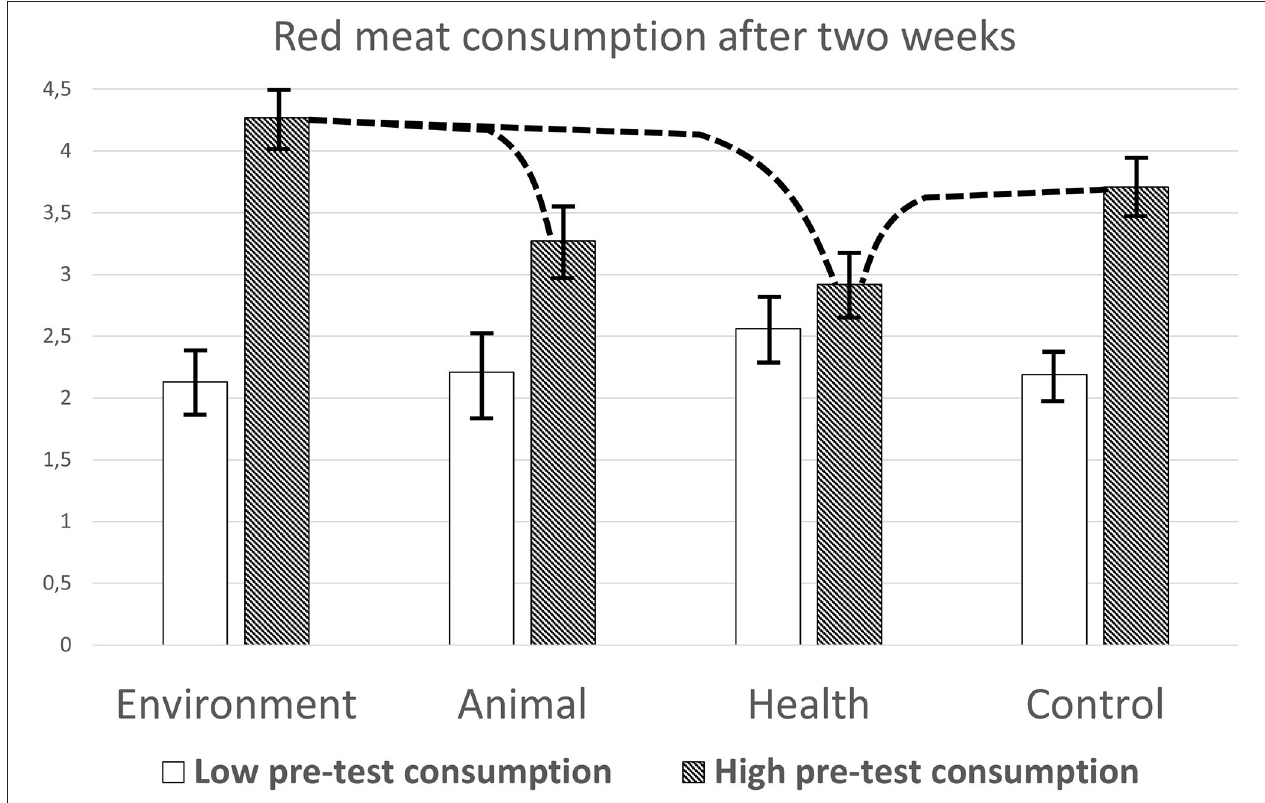
FIGURE 1 | Levels of self-reported red meat consumption after 2 weeks in the four conditions, according to the pre-test level of meat consumption. Dotted lines represent significant contrasts. Error bars refer to standard errors (SEs). control condition shows that health arguments were